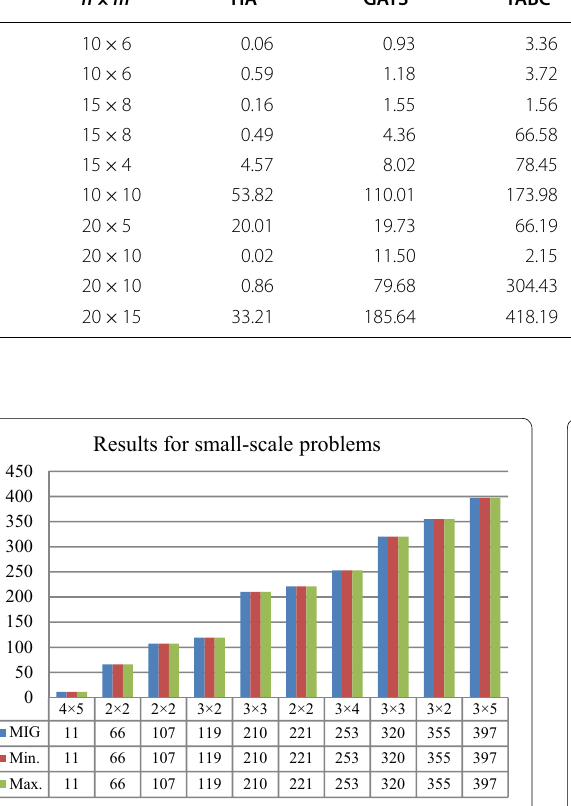
Figure 9 Results comparison for small-scale problems